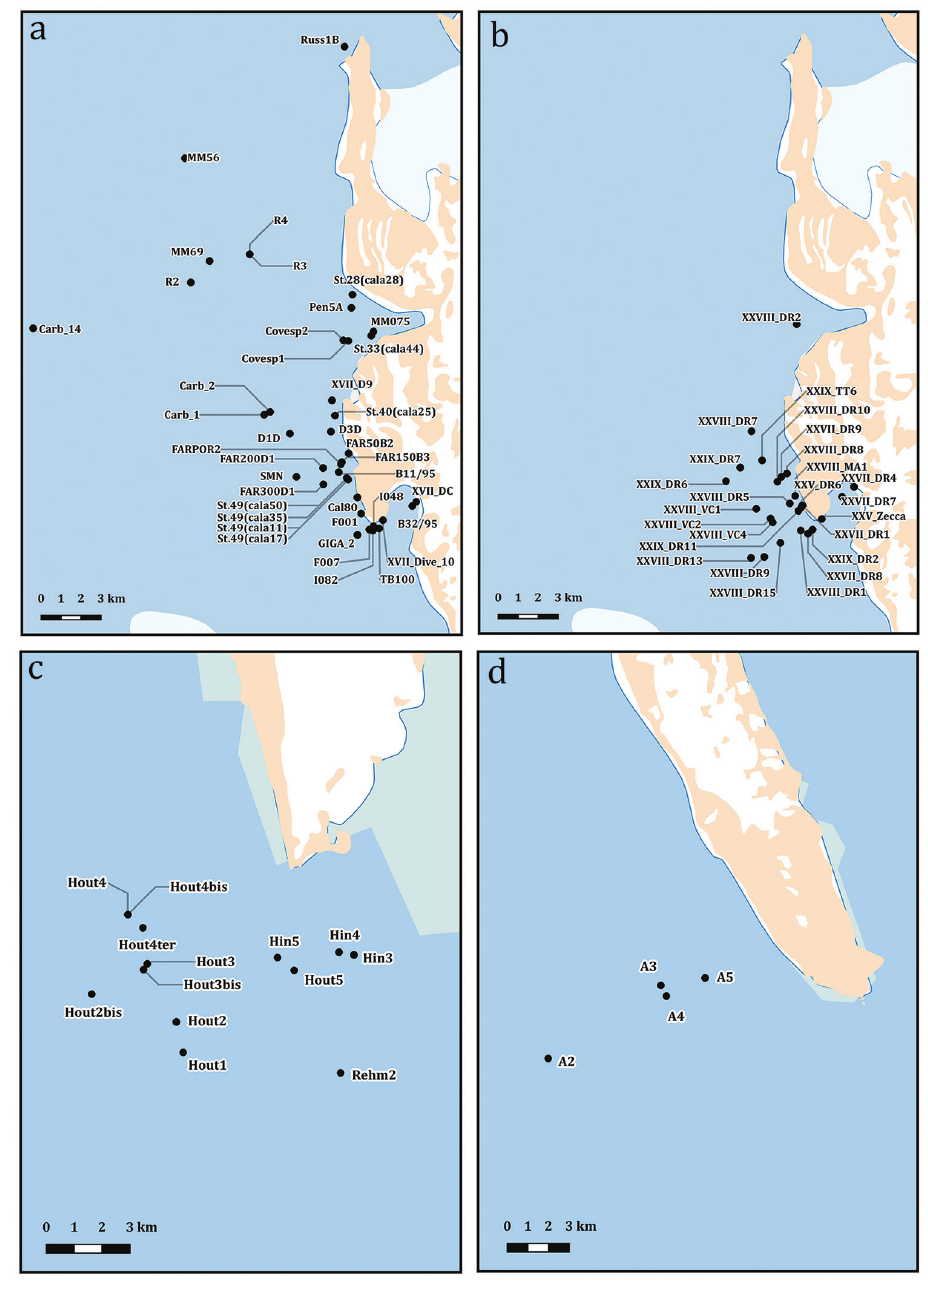
Figure 4. Highlight of the sampling sites in Terra Nova Bay ( a sampling locations from 1988 to 2004 b sampling locations from 2009 to 2014), Cape Hallett ( c ) and Cape Adare ( d )